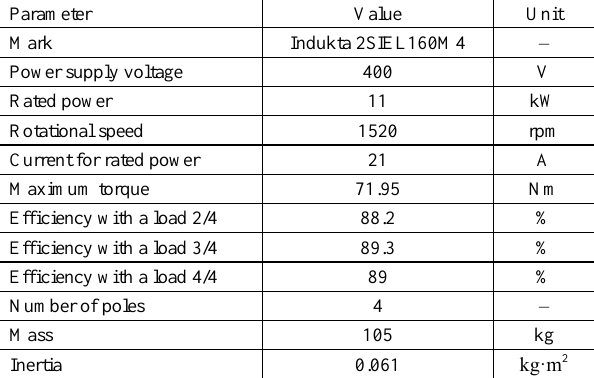
Table 5. Basic construction parameters of the electric machine.